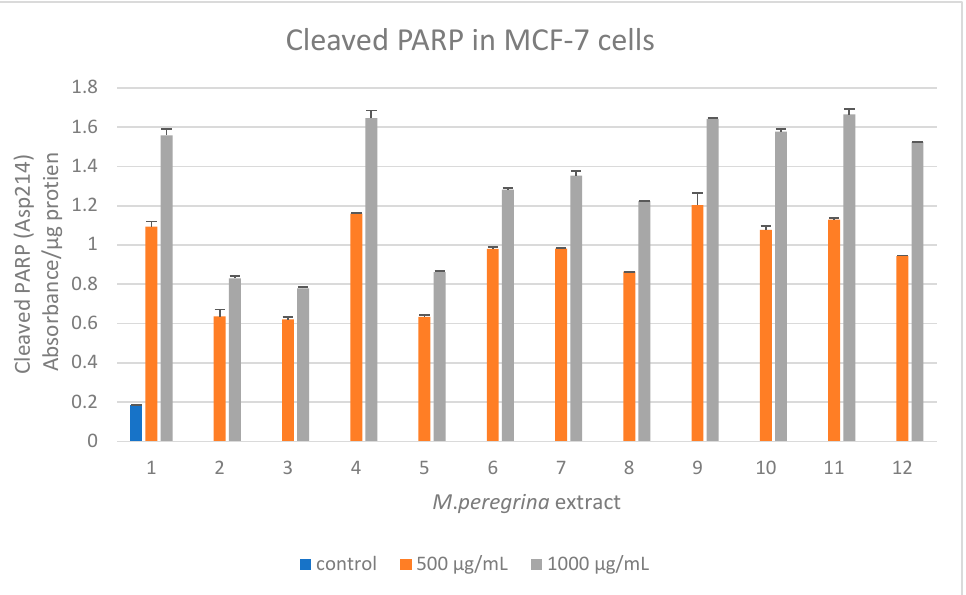
Figure 8. Graphical representation of cell viability percentage of different M. peregrina extracts on Caco-2 with 72 h incubation: ‘1’—Hexane extract (tubers); ‘2’—chloroform extract (tubers); ‘3’—acetone extract (tubers); ‘4’—methanol extract (tubers); ‘5’—hexane extract (leaves); ‘6’—chloroform extract (leaves); ‘7’—acetone extract (leaves); ‘8’—methanol extract (leaves); ‘9’—hexane extract (stem); ‘10’—chloroform extract (stem); ‘11’—acetone extract (stem); ‘12’—methanol extract (stem). One way ANOVA analysis to compare between control, 500 µ g/mL and 1000 µ g/mL of the extract ( p <